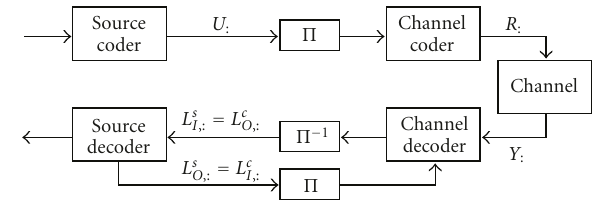
Figure 1: Generic joint source-channel turbo system.